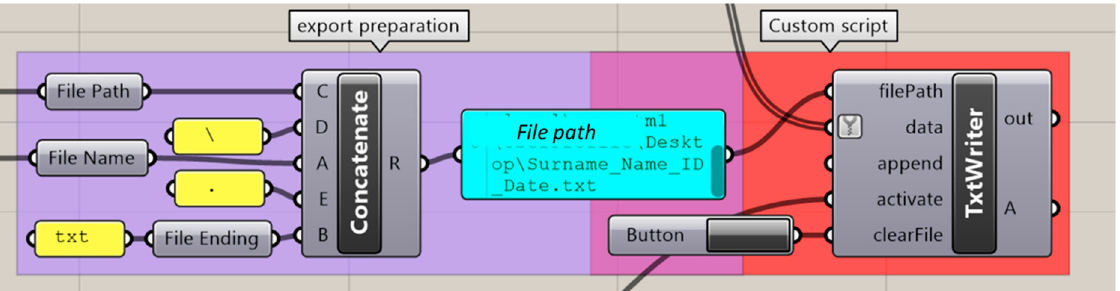
Figure 13. GH commands for measurement export. Background colour coding: Conventional GH commands (purple), custom script (red).